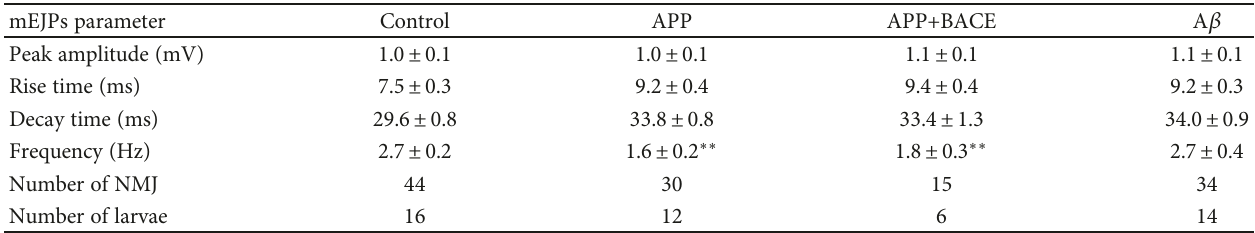
Table 2: Parameters of mEJPs recoded at muscle 6 and 7 neuromuscular junctions from transgenic Drosophila melanogaster larvae. mEJPs